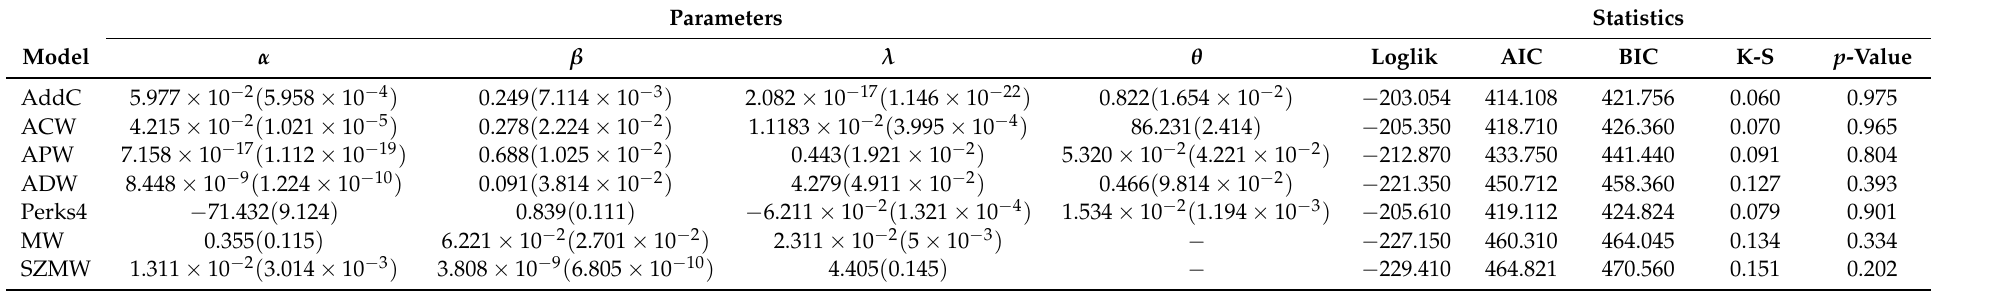
Table 3. Estimated Values, standard errors in brackets and Statistics metrics for the Case of Study